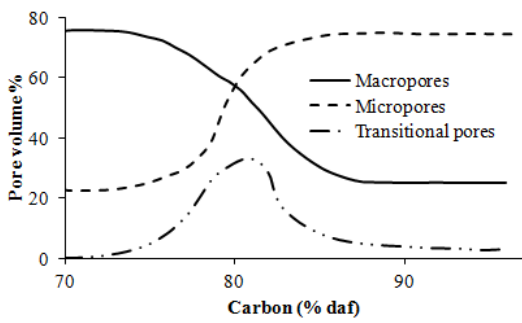
Figure 42. Pore structure of raw American coals on dry and ash-free basis [70].